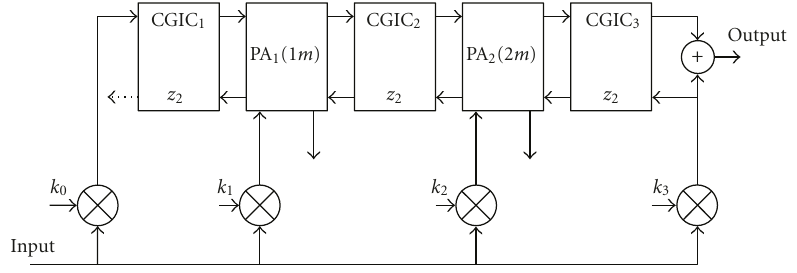
Figure 1: First-order CGIC-PA rotated digital filter structure.